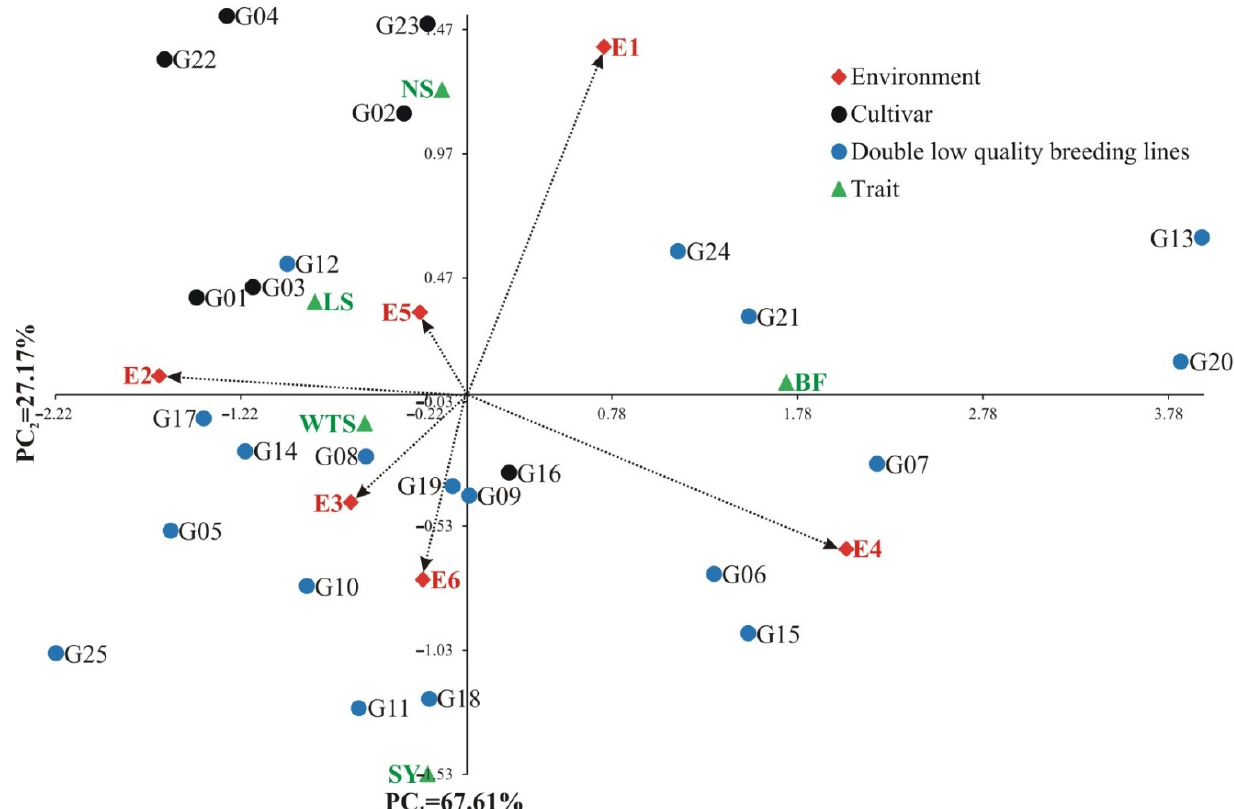
Figure 11. A tri-plot genotype × environment × trait for 25 genotypes of winter oilseed rape. E1—Borowo, 2015; E2—Borowo, 2016; E3—Borowo, 2017; E4— Ł agiewniki, 2015; E5— Ł agiewniki, 2016; E6— Ł agiewniki, 2017. BF—the beginning of flowering, SY—seed yield, LS—length of silique, NS—the number of seeds per silique, WTS—the weight of 1000 seeds.